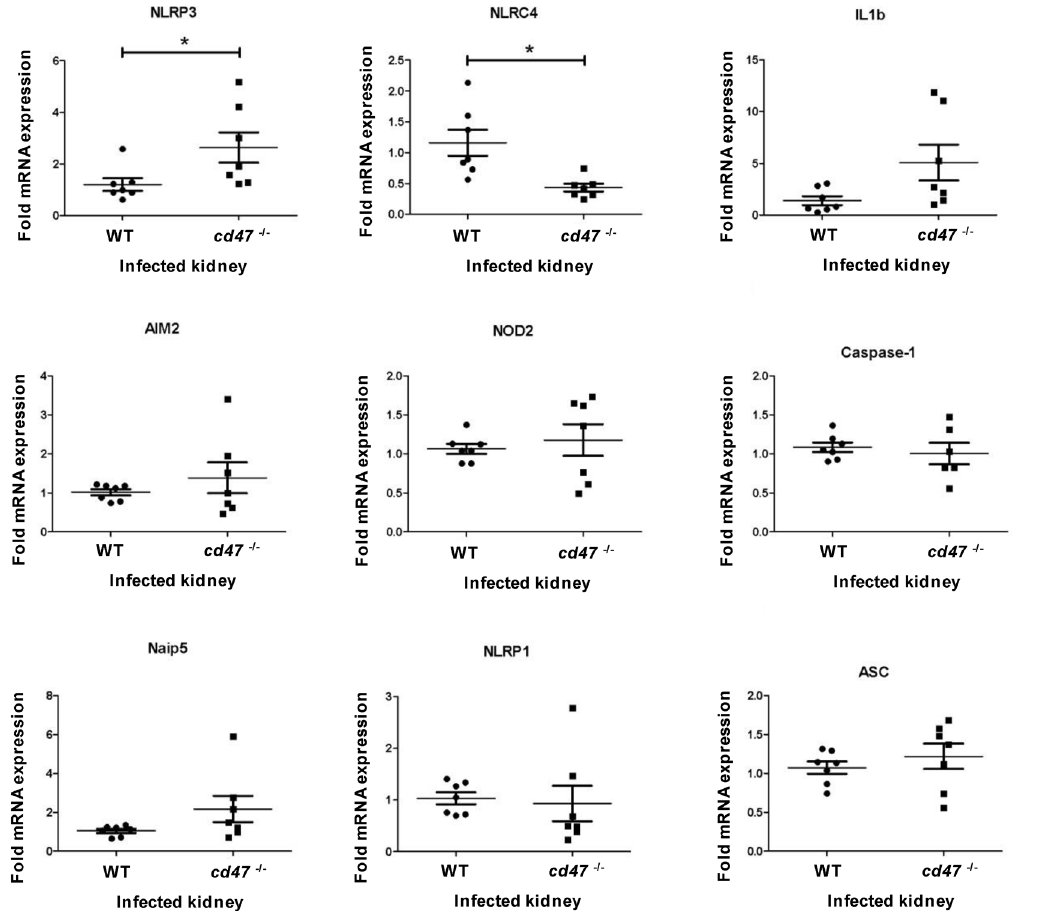
Fig 8. Effect of CD47 on inflammasome pathway gene expression in infected kidney. RNA was purified from kidneys of infected WT and cd47 -/- mice at 4 days PI. cDNA synthesis was performed, and primers to NLRP3, NCLR4, IL1b, AIM2, NOD2, Caspase-1, Naip5, NLRP1, and ASC were used to quantify mRNA expression levels and normalized to HPRT expression. Each mouse is plotted as individual point, and standard error mean is indicated with a horizontal line. Student ’ s t test was used to calculate significant (p < 0.05) and indicated ( * ).